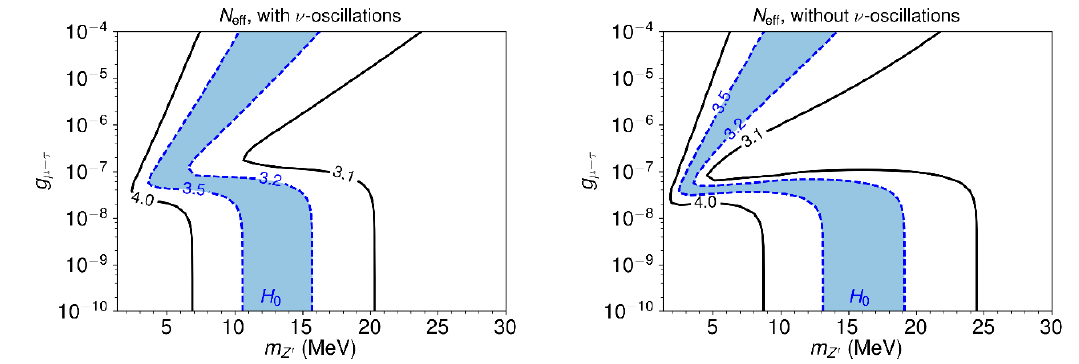
Figure 6 . As in (cid:12)gure 5, but for smaller values of g (cid:22) (cid:0) (cid:28) and for the case of (cid:15) = g (cid:22) (cid:0) (cid:28) = 70.